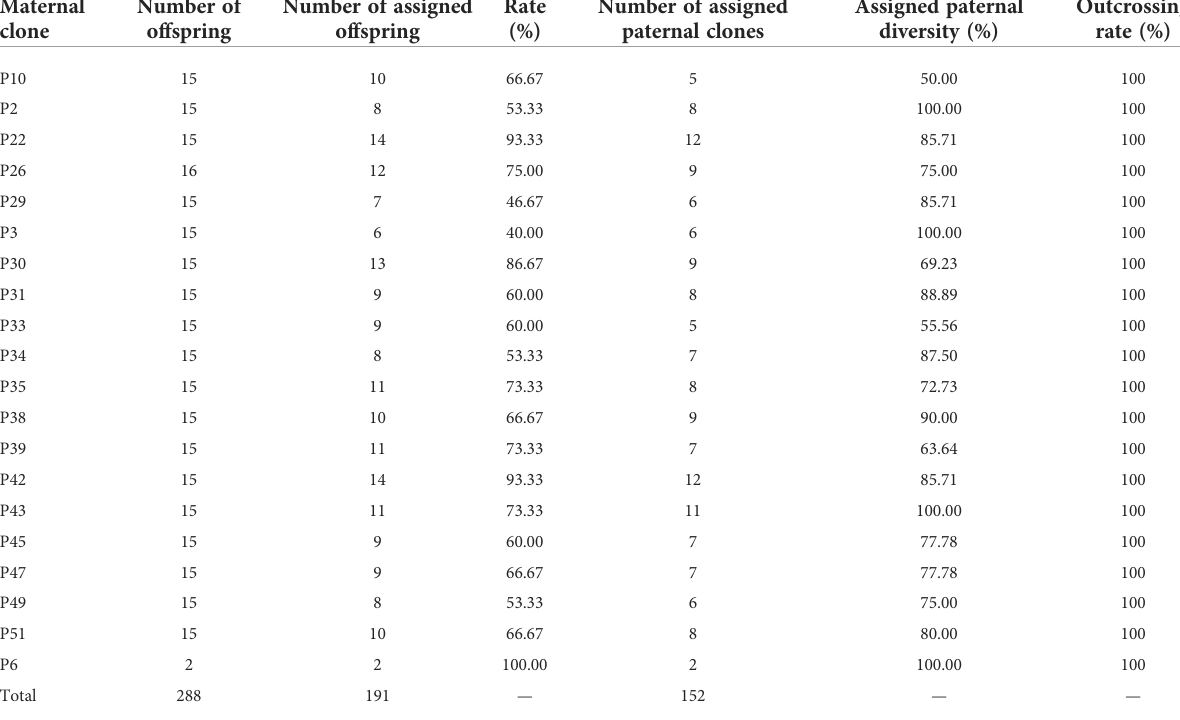
TABLE 2 Paternity analysis for the 288 offspring.